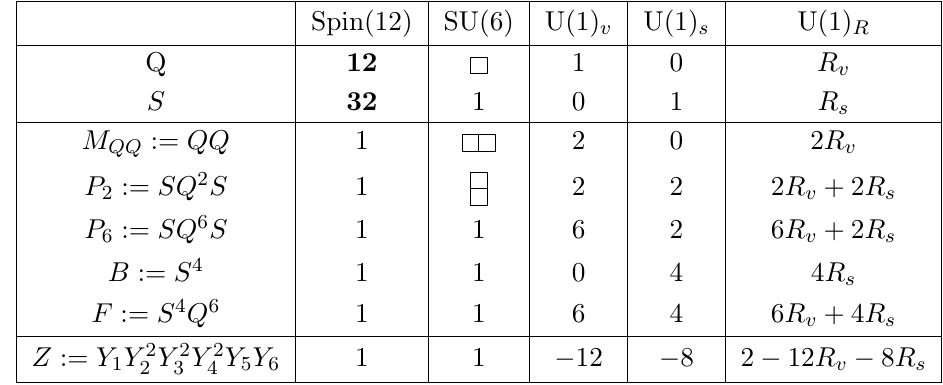
Table 20 . 3d N = 2 Spin(12) theory with ( N v ; N s ; N s 0 ) = (6 ; 1 ;